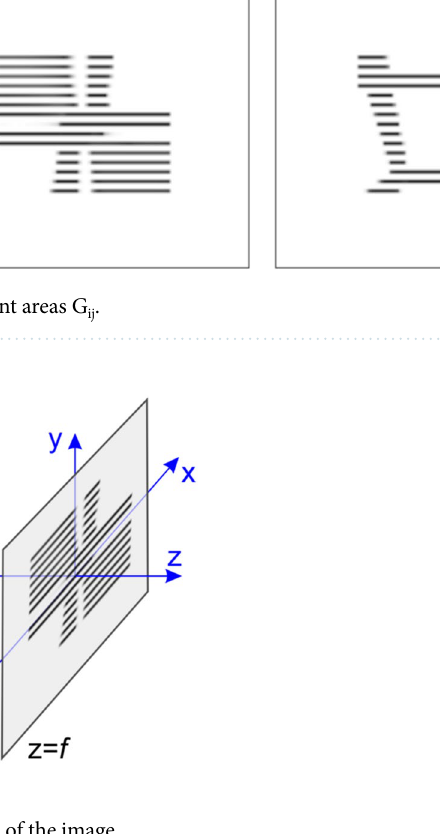
Figure 9. Optical scheme of the formation of the